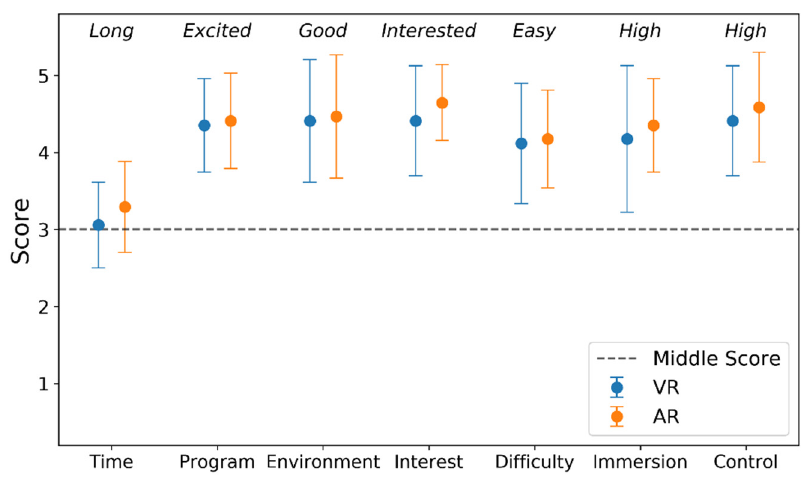
Figure 9. Users’ satisfaction with VR and AR.